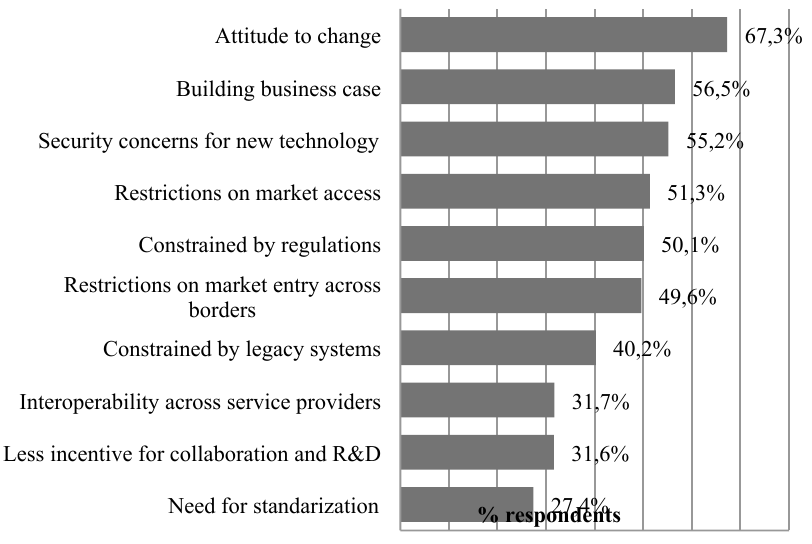
Fig. 2. Key retail payment innovations drivers (% of responders)